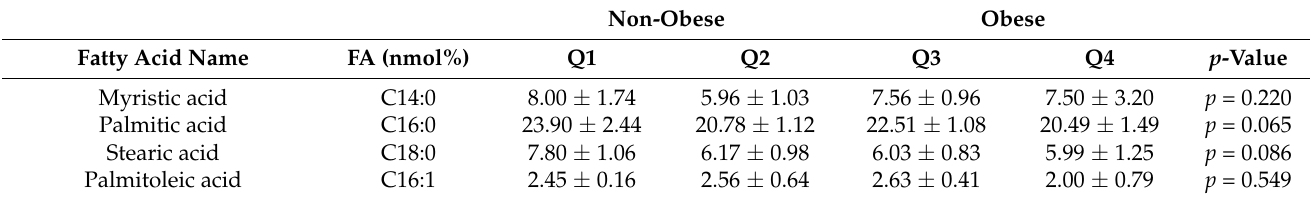
Table 3. The fatty acid composition of breast milk by quartiles with low and high n-6:n-3 PUFA ratios. Non-Obese